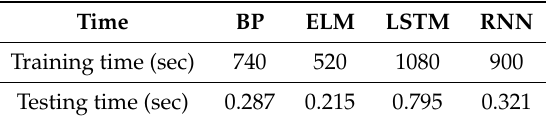
Table 3. Training and testing time of all